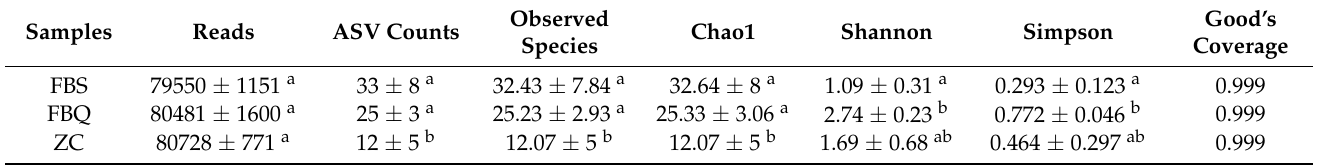
Table 3. Fungal alpha diversity index of normal and spoiled Mianning